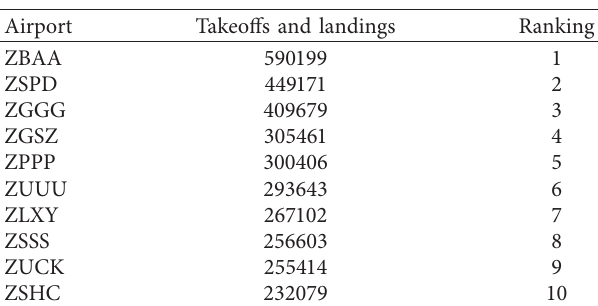
Figure 9: (a) Time varying airport states of airport ABNY. (b) Time varying air traffic flow volume of airport ABNY. In (a), “1” represents infected state, “2” represents susceptible state, and “3” represents recovered state. Table 5: The top 10 airports.